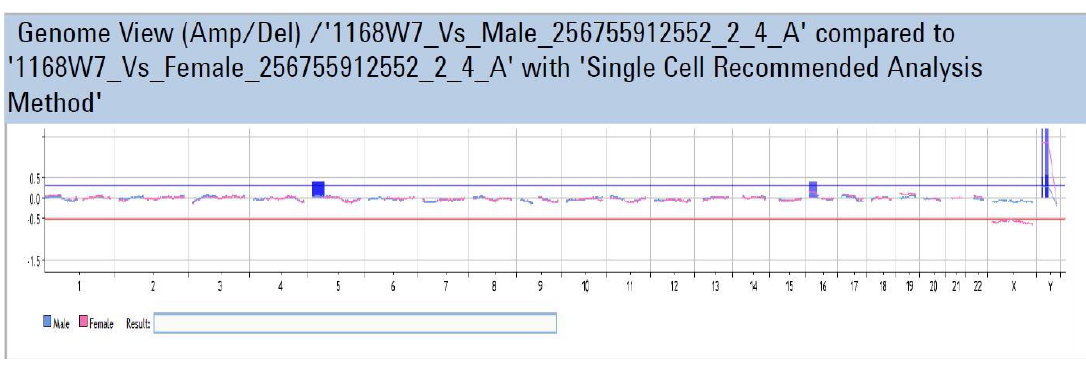
Figure A5. Male embryo, aneuploid, arr. 5p15.33p12(981,535—44,667,248)x3, 16p13.3p11.2(261,626- 32,165,798)x3.